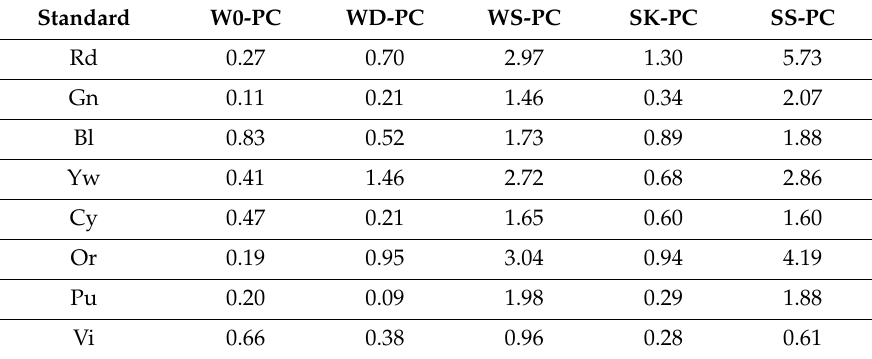
Table 5. ∆ E* ab values obtained for all standards considering as target the measurement made with the PC adjustment and as samples the measurements carried out with other adjustment conditions (see Table